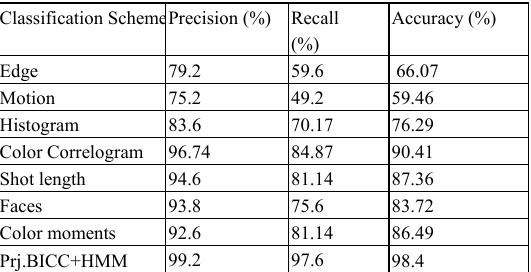
Fig. 6 BICC with HMM for different